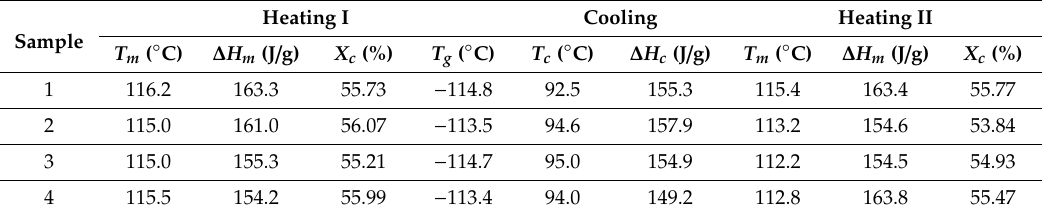
Table 2. Glass transition temperature, melting and crystallization characteristics of low-density polyethylene (LDPE) and relative